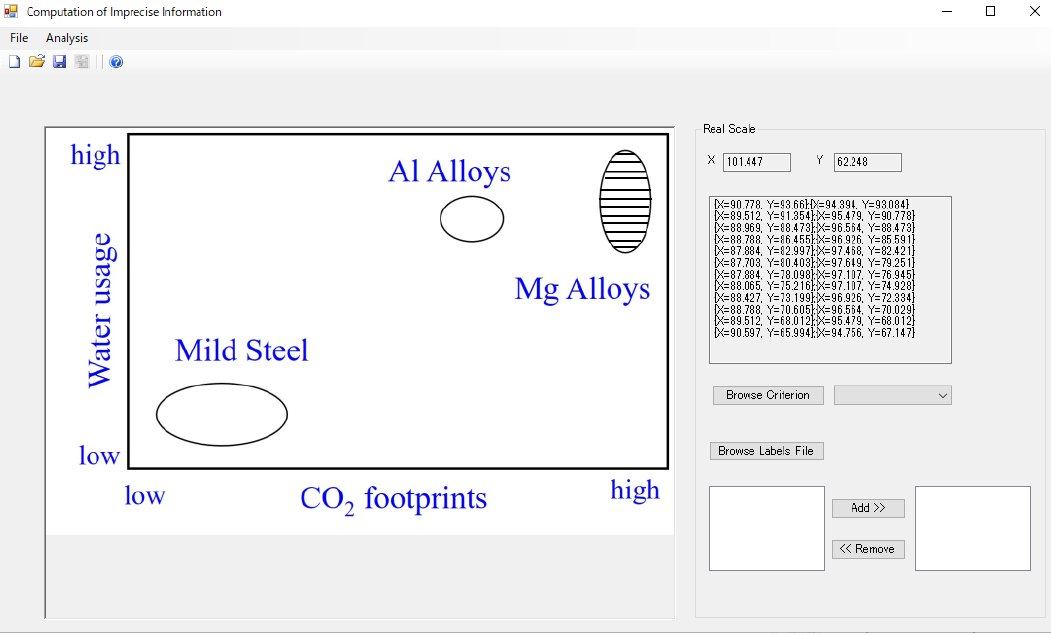
Figure 12. Extracting decision-relevant information from the plot of water usage versus CO 2 foot- print. Table 3. Decision scores ( D s) of the alternatives with respective to the respective criteria.